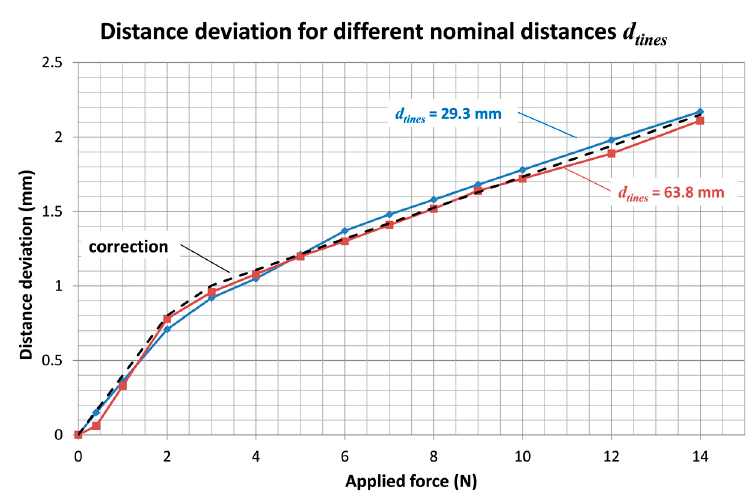
Figure 10. Distance deviation due to the applied separating force.